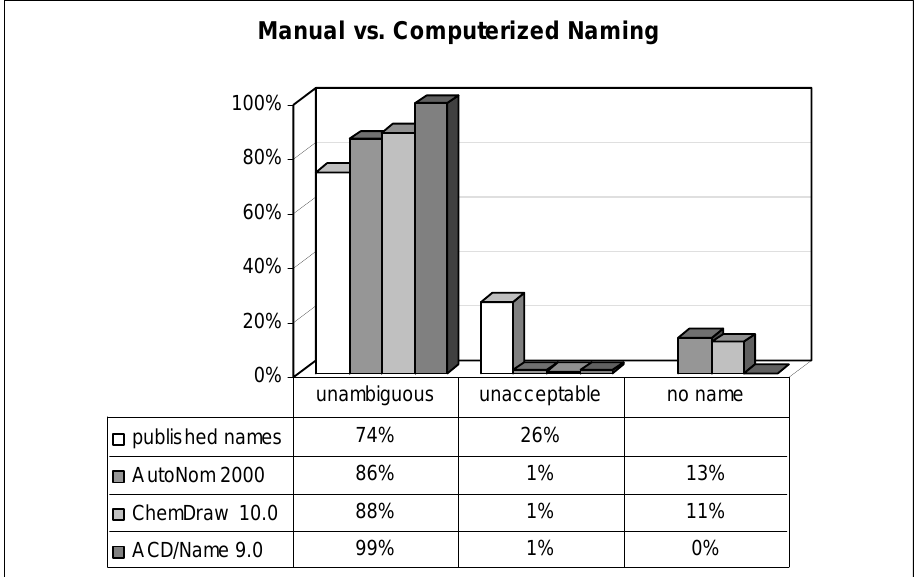
Figure 2 . Comparison of published names with computer-generated ones (n = 303).